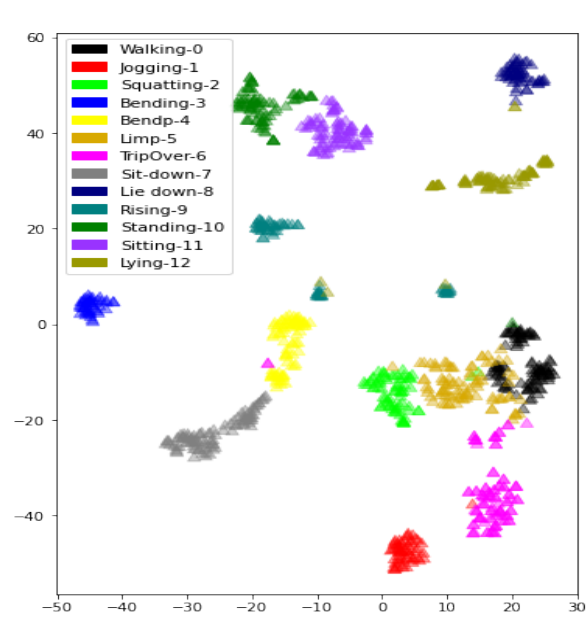
Fig 13. The decision tree would build relationships between features and